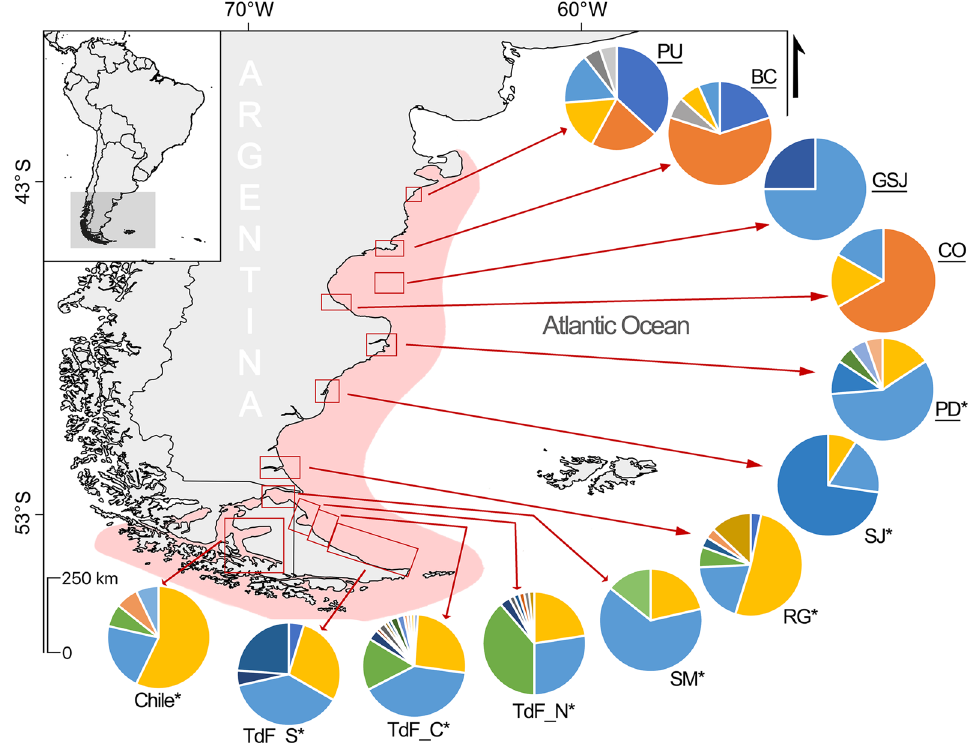
Figure 1. Study area showing Cephalorhynchus commersonii distribution in red shadow. Sampling sites underlined correspond to present study, whereas those with asterisk (*) indicate the localities for the mitochondrial DNA control region sequences from Cipriano et al. 41 and Pimper et al. 42 . PU = Playa Unión, BC = Bahía Camarones, CO = Caleta Olivia, GSJ = Golfo San José, PD = Puerto Deseado, SJ = San Julián, RG = Río Gallegos, SM = Strait of Magellan, TdF = Tierra del Fuego (N = North, C = Center, S = South). Pie charts represent the respective frequency of mitochondrial DNA control region haplotypes from each sampling location. The map was created in QGIS 3.12 (https:// www. qgis. org/ es/ site/), whereas the final figure edition was generated using Photopea online graphics editor (https:// www. photo pea.